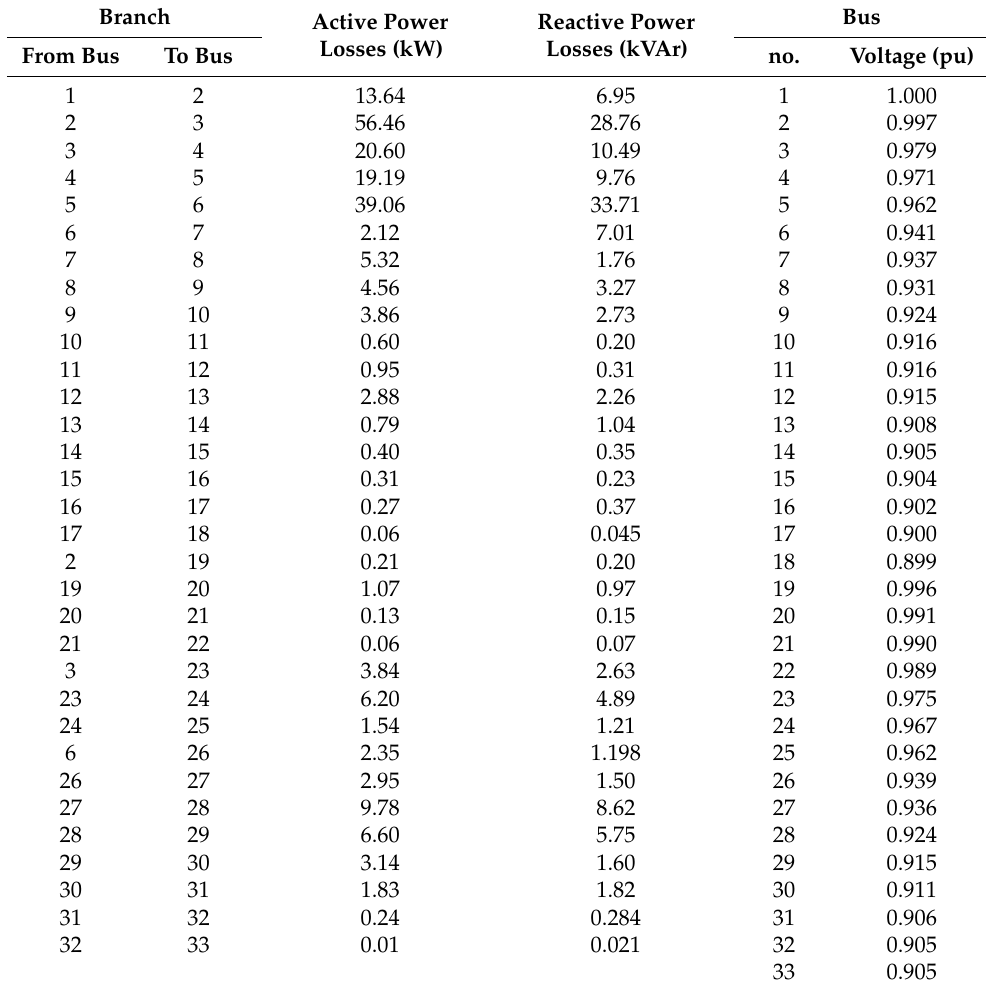
Table 5. IEEE 33-bus system load flow results for 100% loading without